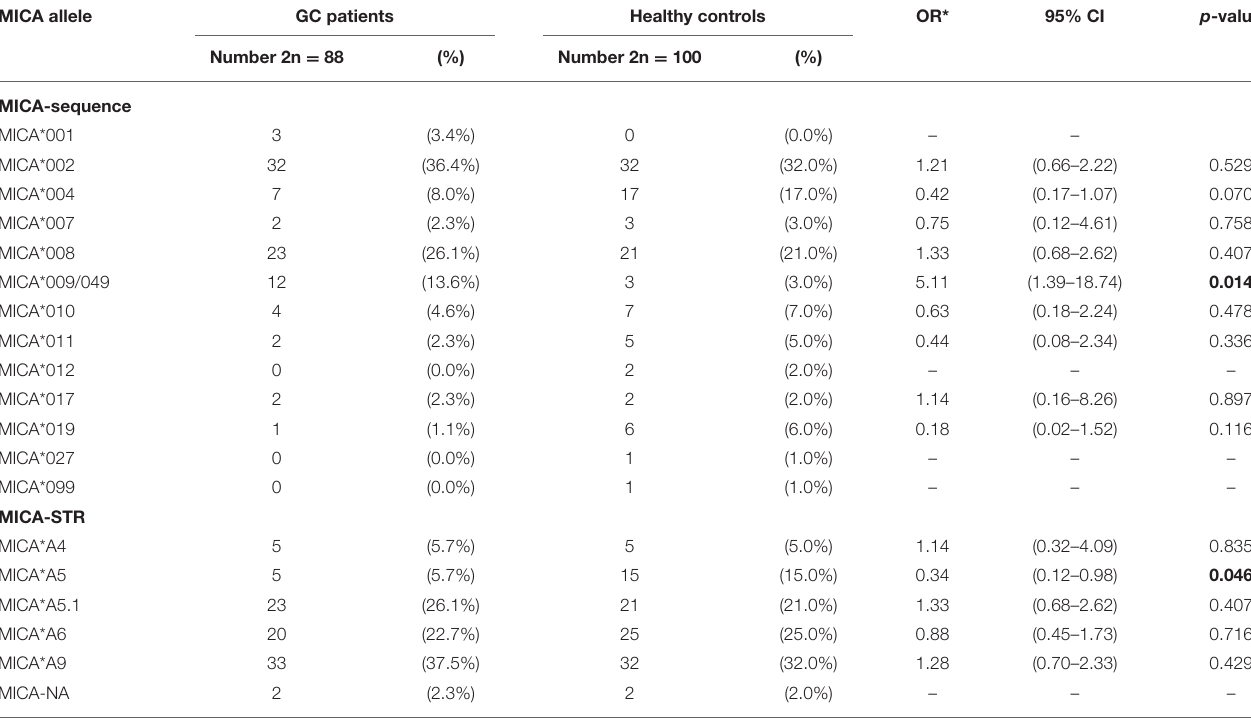
TABLE 2 | MICA allelic frequency in gastric cancer patients and healthy controls. MICA allele GC patients Healthy controls